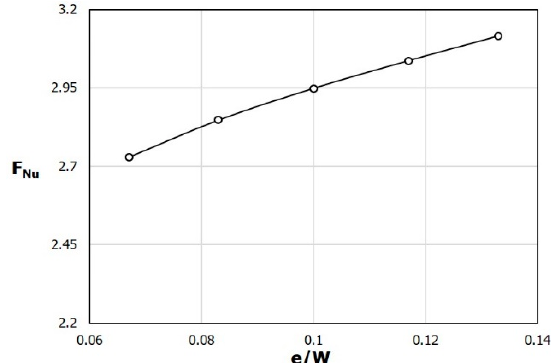
Figure 10. Variation of F Nu with e/W (h/H = 0.5).